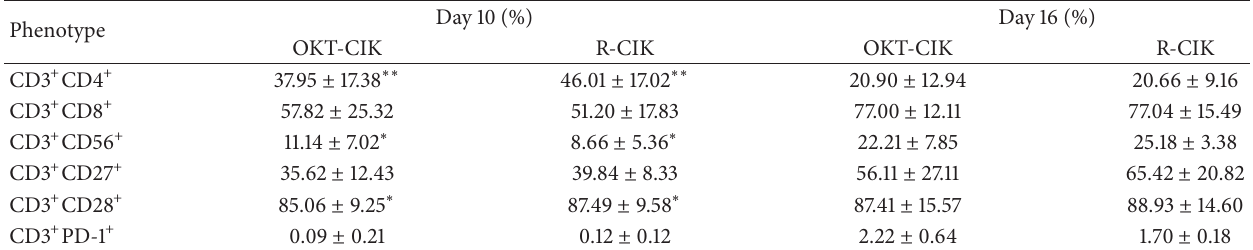
Table 2: The cell phenotype of CIK at different culture time ( 𝑥 ± 𝑠 , 𝑛 = 5